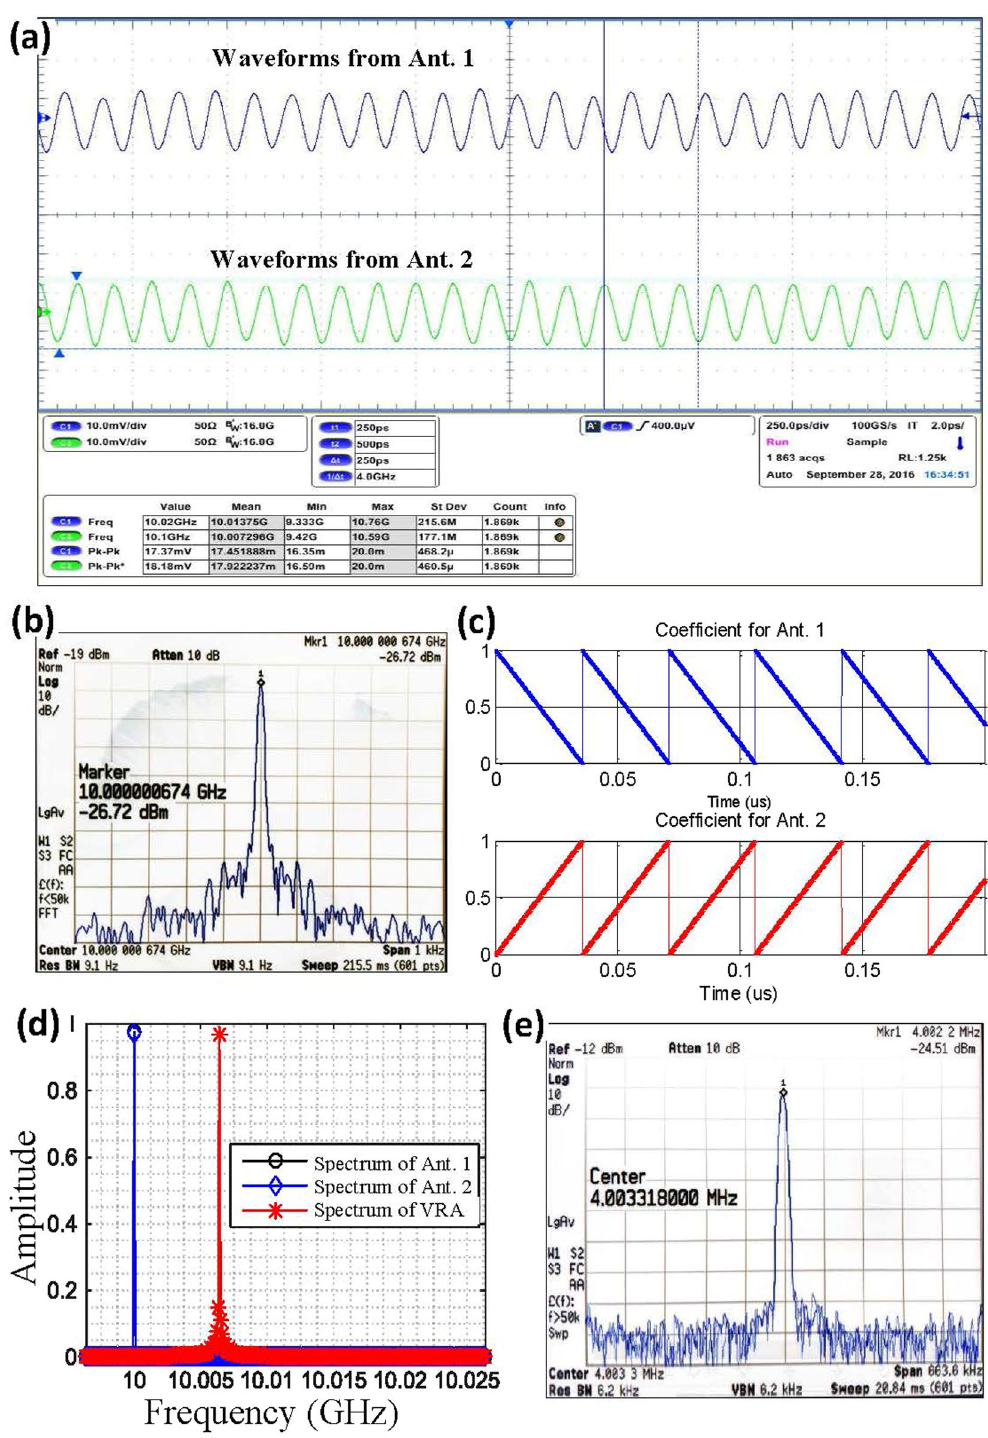
Figure 4. Signals and spectrum observed for OAM mode detection using the VRA. ( a ) Signals received from two antennas. ( b ) Observed spectrum of the signal received from one antenna. ( c ) Weighting coefficients used for interpolation in the experiment. ( d ) Frequency shift detection of the interpolated signal. ( e ) Observed spectrum of the interpolated signal exported from the computer. The interpolated signals were down-converted to zero intermediate frequency by mixing with a carrier signal of 10 GHz frequency and digitally filtered using a low-pass filter. The down-converted signals were then exported from the computer to a signal processing board for data playback. A spectrum analyser was used to observe the spectrum (see Fig. S8 in Supplementary